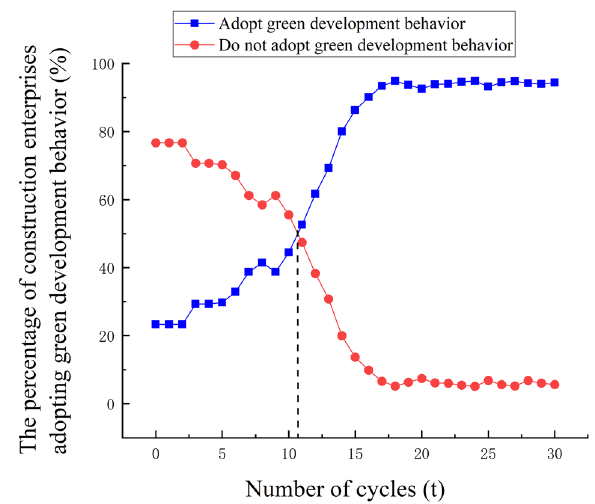
Fig. 3 The dynamic process of adopting green development behaviors in construction enterprises in the control group. The moment marked with dotted line in the fi gure represents that in the initial situation of A = 25%, the proportion of construction enterprises adopting green development behavior in the model is consistent with that of those not adopting green development